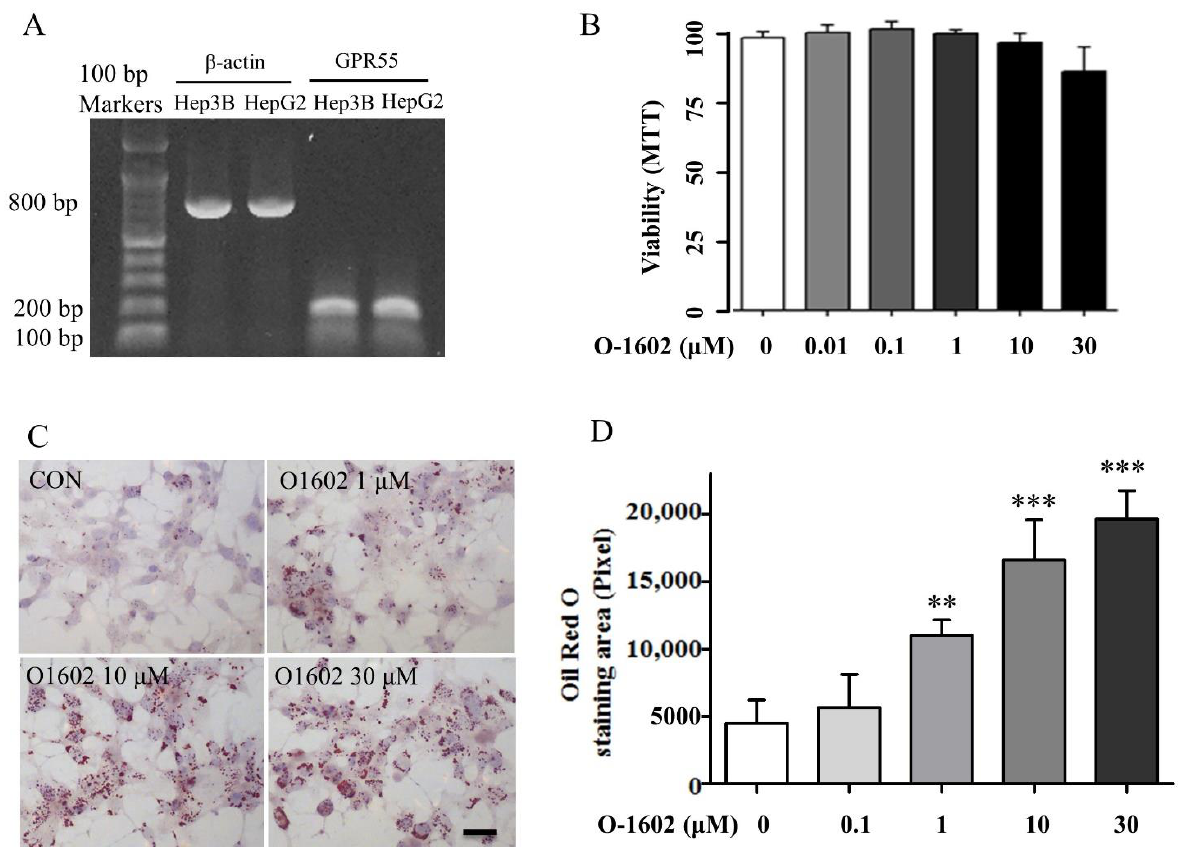
Figure 1. Expression of GPR55 and O-1602-induced lipid accumulation in Hep3B cells. ( A ) GPR55 RT-PCR results in Hep3B and HepG2 cells. ( B ) Viability test of O-1602 in Hep3B cells. ( C ) Oil red O staining. Hep3B cells were treated with different concentrations of O-1602 for 48 h. The red staining shows lipid droplets. The scale bar means 20 µ m. ( D ) Histogram showing lipid accumulation. Oil red O staining was analyzed using ImageJ software (NIH, Bethesda, MD, USA). Data are from three individual experiments and expressed as mean ± SD. ** p < 0.01, *** p < 0.001, compared with the non-treated group.